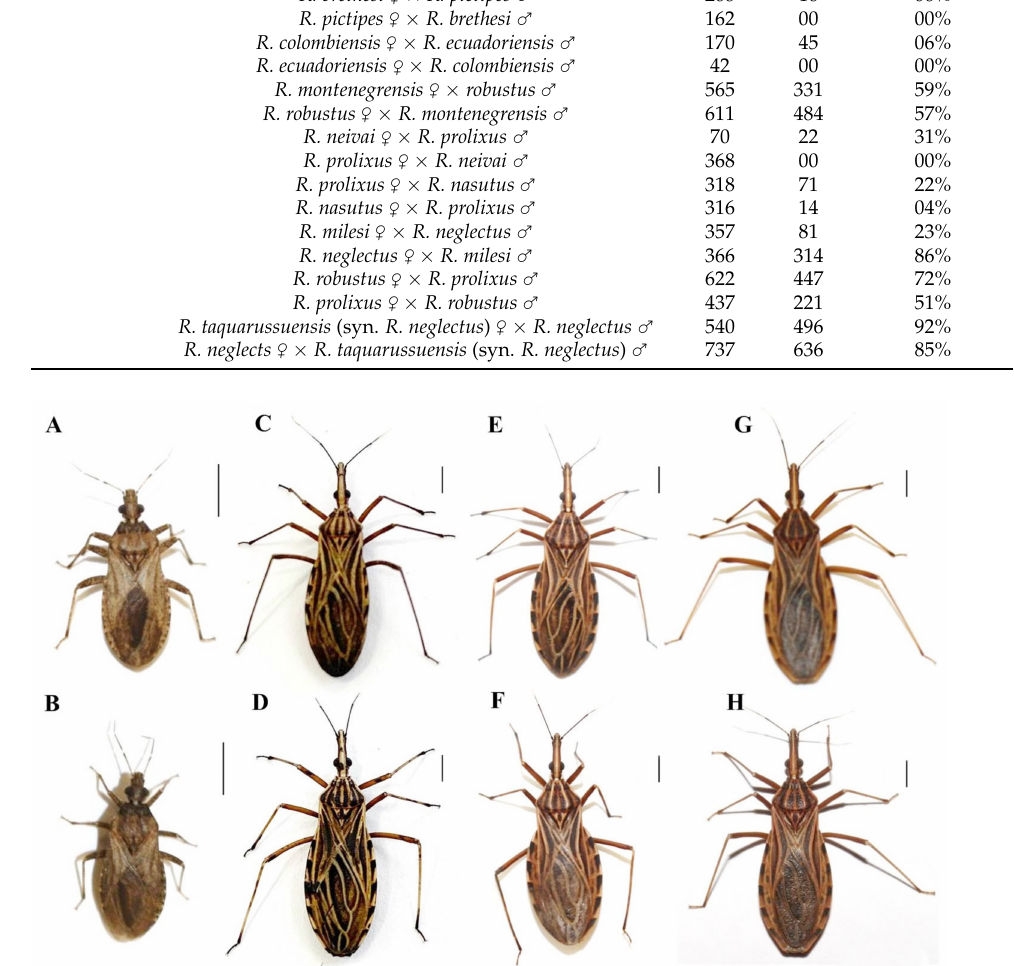
Figure 1. Hybrids resulting from crosses between species of the Rhodniini tribe. Hybrids resulting from crosses between P.